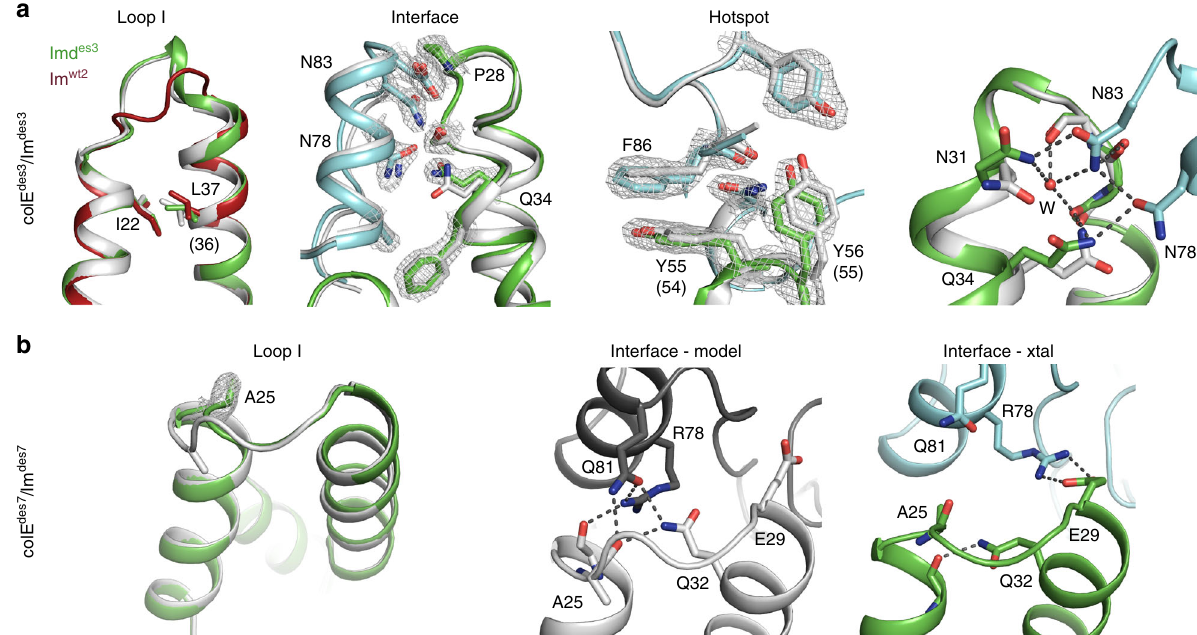
Fig. 7 Crystallographic analysis of speci fi c and multispeci fi c colE/Im pairs. a The crystal structure of the speci fi c colE des3 /Im des3 (cyan/green, PDB entry 6ERE) veri fi es the accuracy of the computational design (gray). The designed Im loop I backbone is within 0.5 Å C α rmsd and the interactions between the colE and Im, including the hotspot residues, are atomically accurate, as is the rigid-body orientation. A water molecule (w), which was not modeled by Rosetta, participates in the designed interfacial hydrogen-bond network. The large difference in loop I conformation and indels relative to Im wt2 (16 amino acids in Im des3 compared to 15 in Im wt2 , in scarlet) and the other designs promote speci fi city. Numbers in parentheses refer to Im wt2 numbering. b The crystal structure of the multispeci fi c colE des7 /Im des7 (cyan/green, PDB entry 6ER6) shows a local conformational change relative to the design in loop I centered on Ala25, but the backbone conformation is within 0.7 Å C α rmsd of the design model. This local conformational change prevents the formation of a designed hydrogen-bond